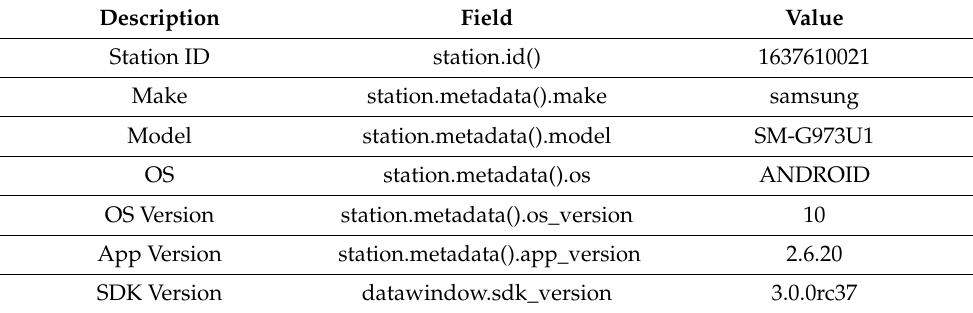
Table 3. Smartphone Station